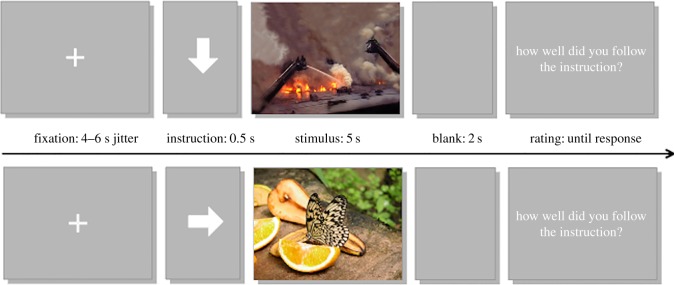
Experimental task. Stimuli were shown for 5 s following 2 s of instruction (arrow). After stimuli, a blank screen was shown for 2 s, and after that participants were asked to rate how well they succeeded with the task on a 7-point scale. A cursor was initially placed on ‘4’. Note: The stimuli shown in this figure are not IAPS pictures and were not included in the task.